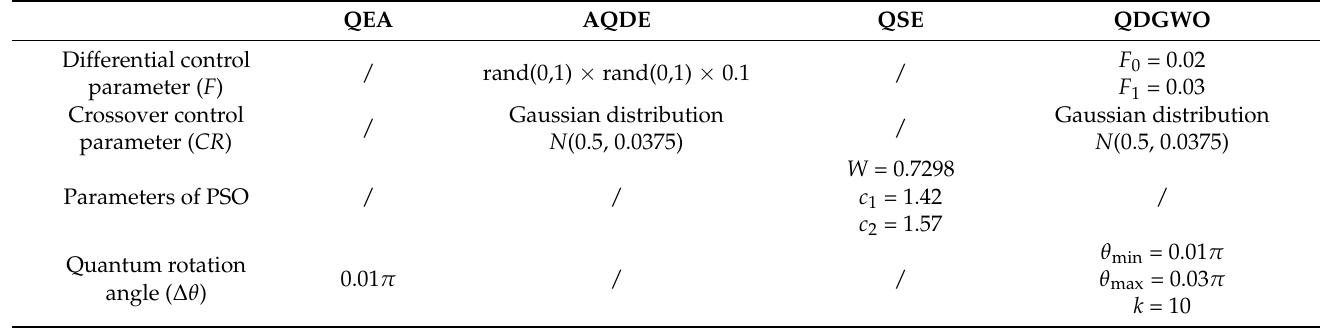
Table 2. Parameters of algorithms in